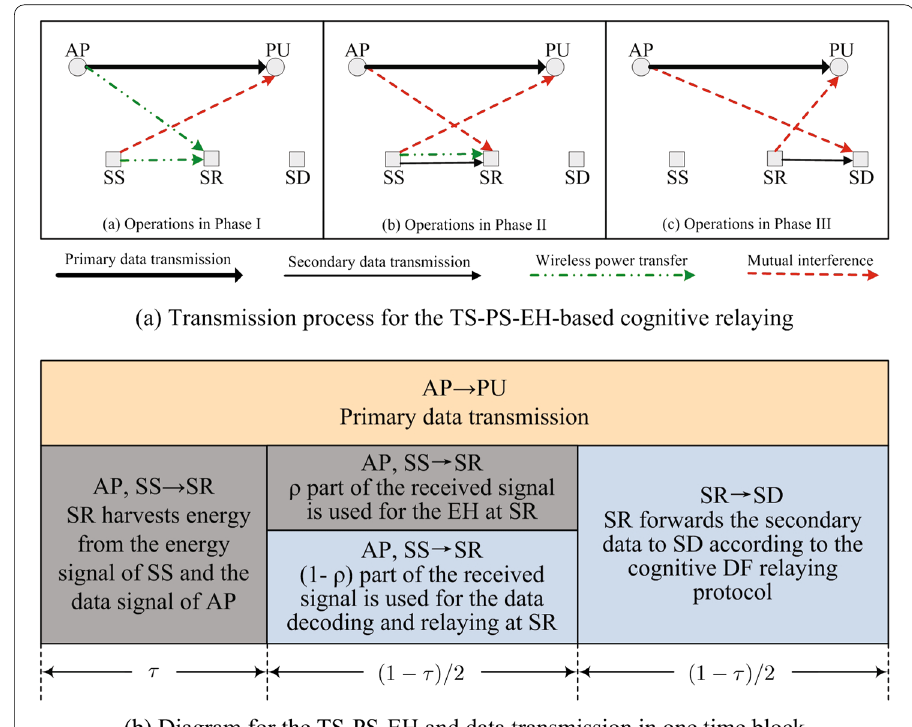
Fig. 1 Cognitive DF relaying with TS-PS-EH at